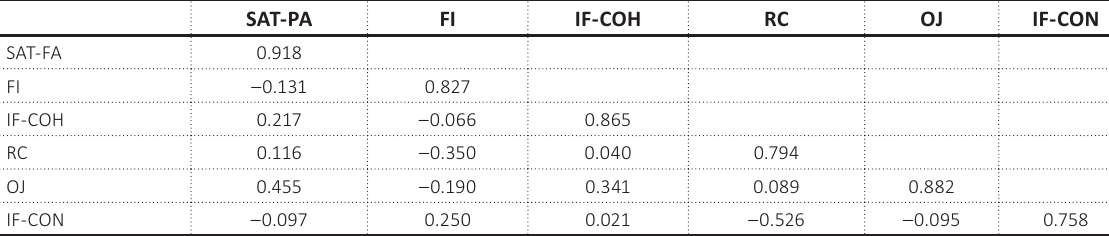
Table 3. Correlations among latent variables and square roots of